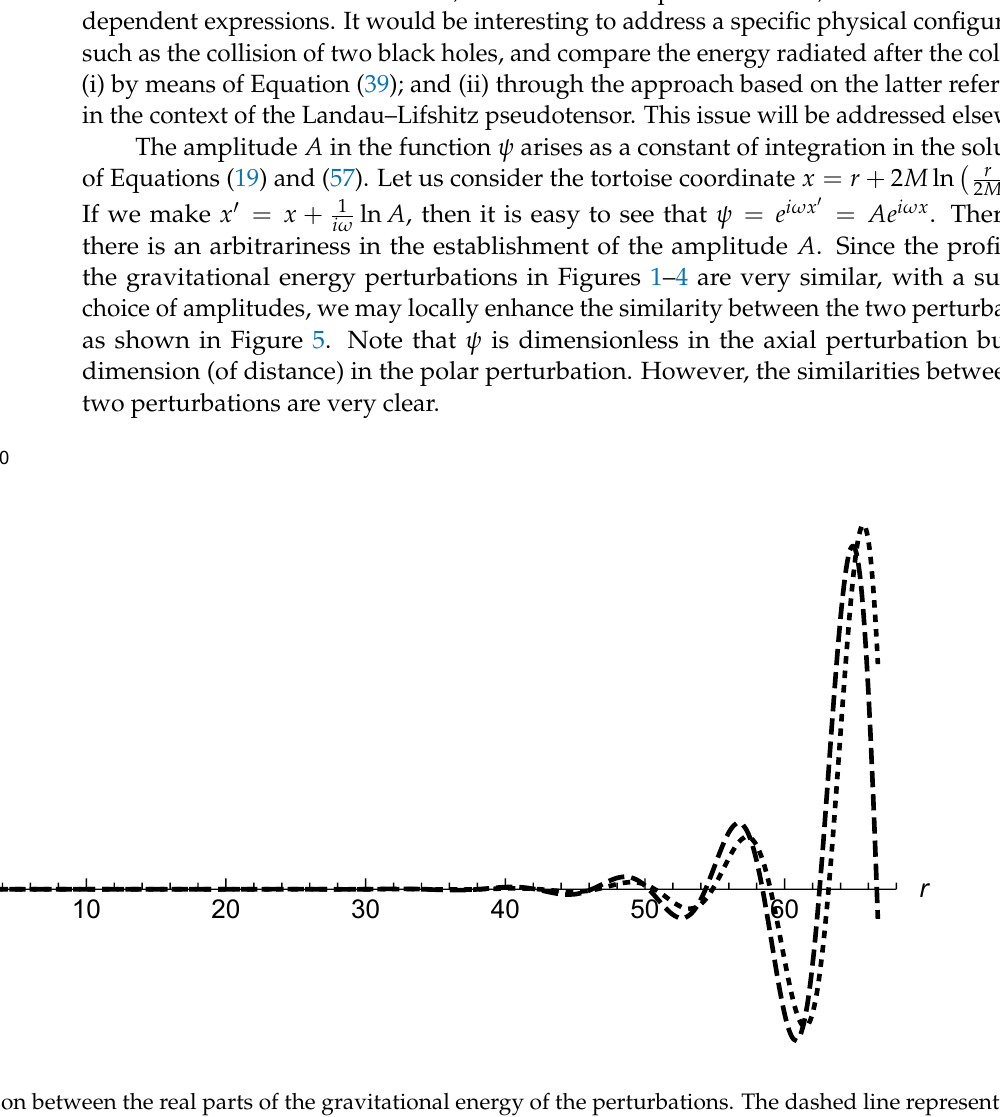
Figure 5. Comparison between the real parts of the gravitational energy of the perturbations. The dashed line represents the numerical expression of the energy for the axial perturbations and the dotted line represents the numerical energy of the polar perturbations. In natural units (whenever necessary), we have A axial = 10 − 6 , A polar = 5 − 1/2 10 − 6 , m = 1, and the frequency (fundamental, ( n = 0, l = 2)) is ω = 0.373162 − i 0.089217, obtained by means of the third-order WKB method. The data represent the initial instant of time of the perturbations, i.e., t =